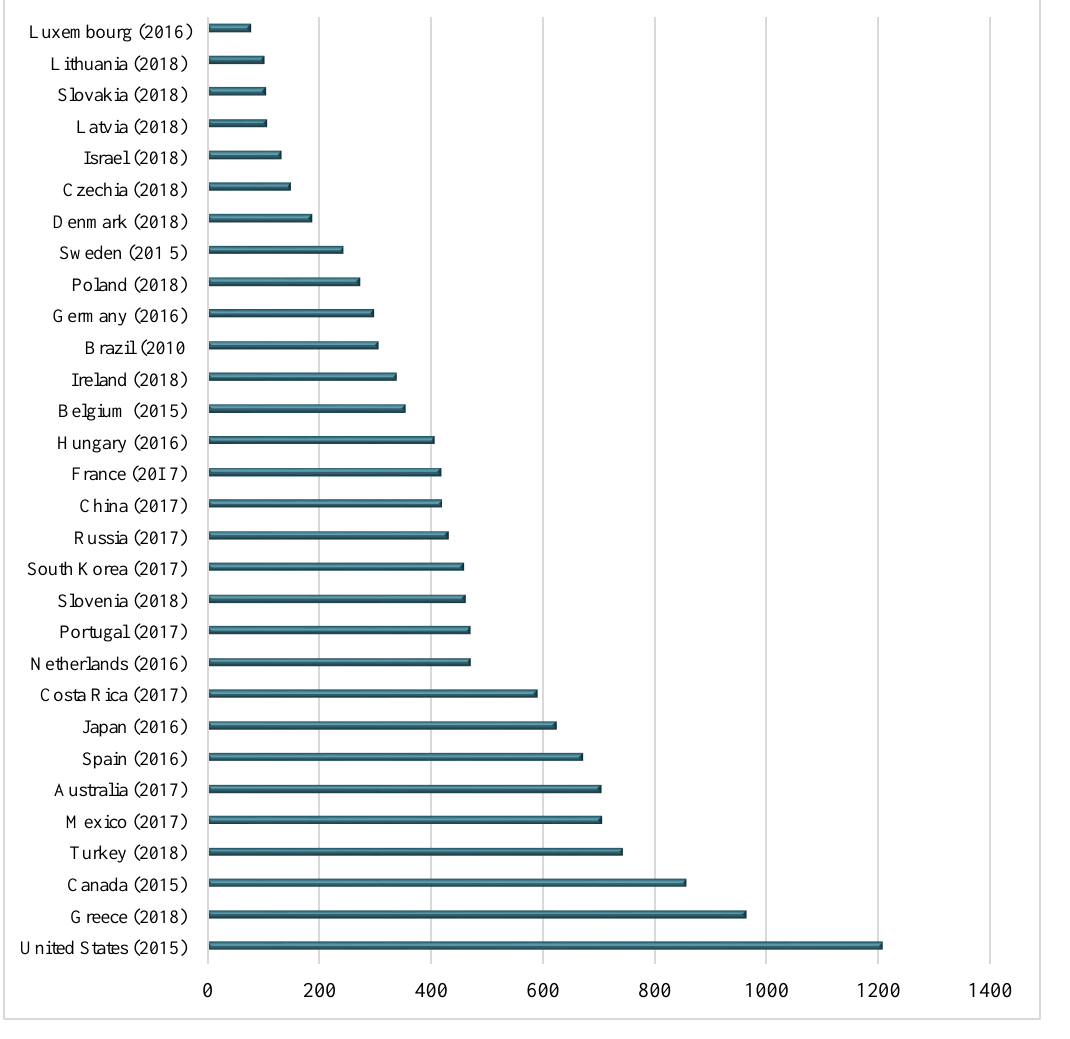
Figure 1. Water consumption per capita per cubic meter (www.statista.com,